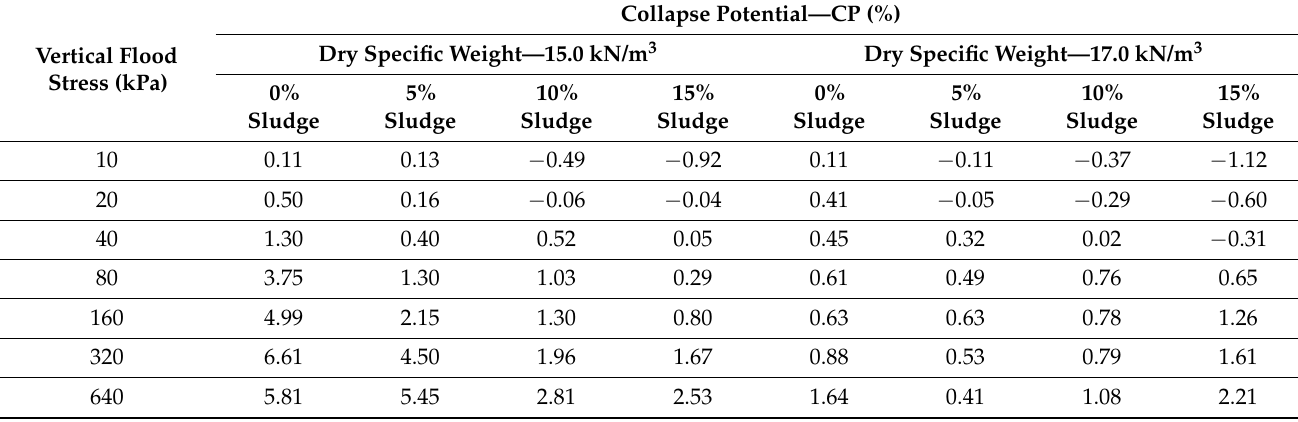
Table 4. Collapse potential of simple oedometer